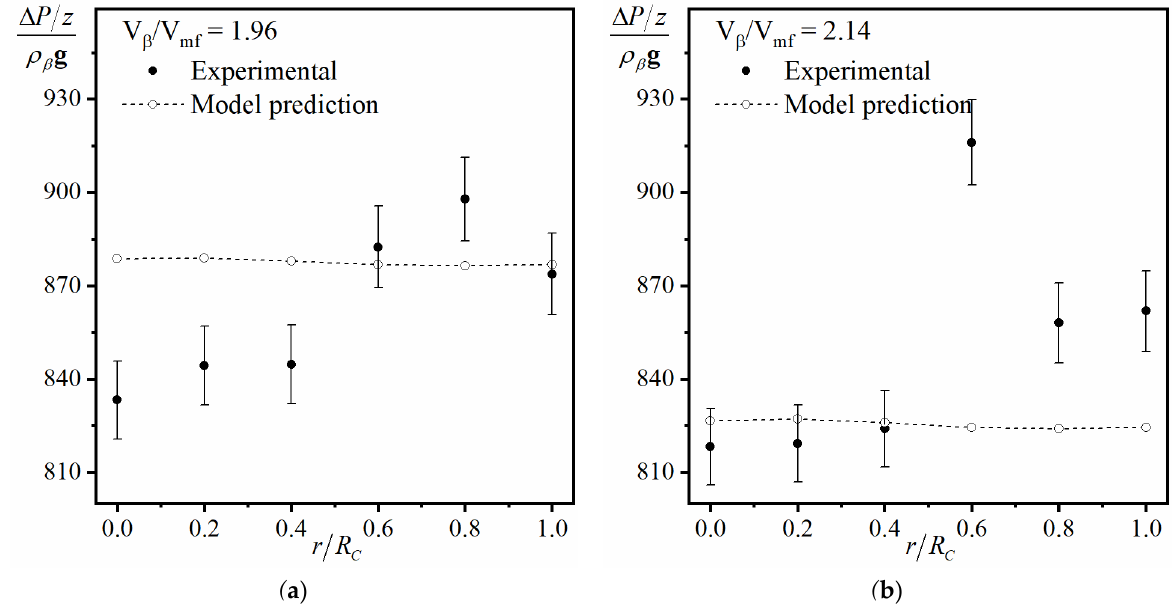
= 14 cm at ( a ) (cid:10) V β (cid:11)